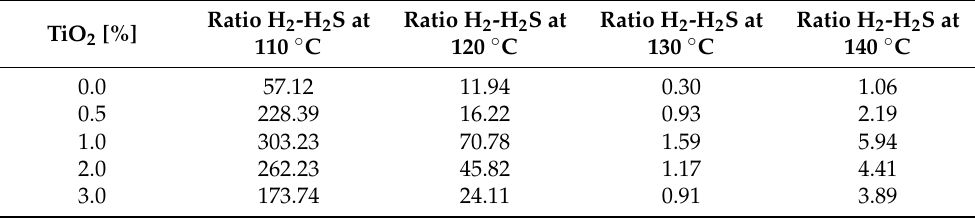
Table 3. Ratio of the produced hydrogen and H 2 S in the cathode of the